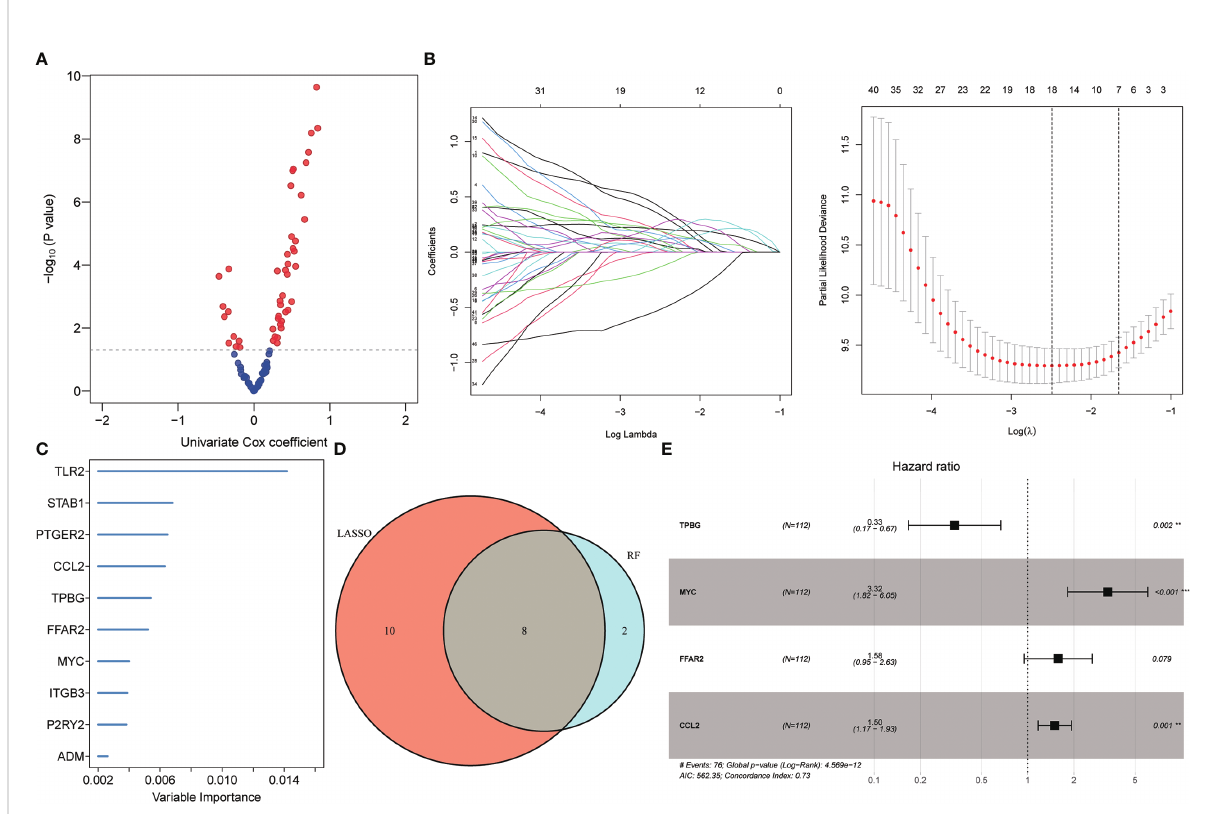
FIGURE 2 Identifying prognostic biomarkers. (A) Univariate Cox regression identifying genes associated with IPF prognosis. (B) Lasso regression further identifying prognosis-related genes. (C) Random Forest identifying the top 10 genes that are relatively important in prognosis. (D) Wayne diagram identifying the common genes selected by the two methods. (E) Multivariate stepwise Cox regression fi nally determined the prognosis- related